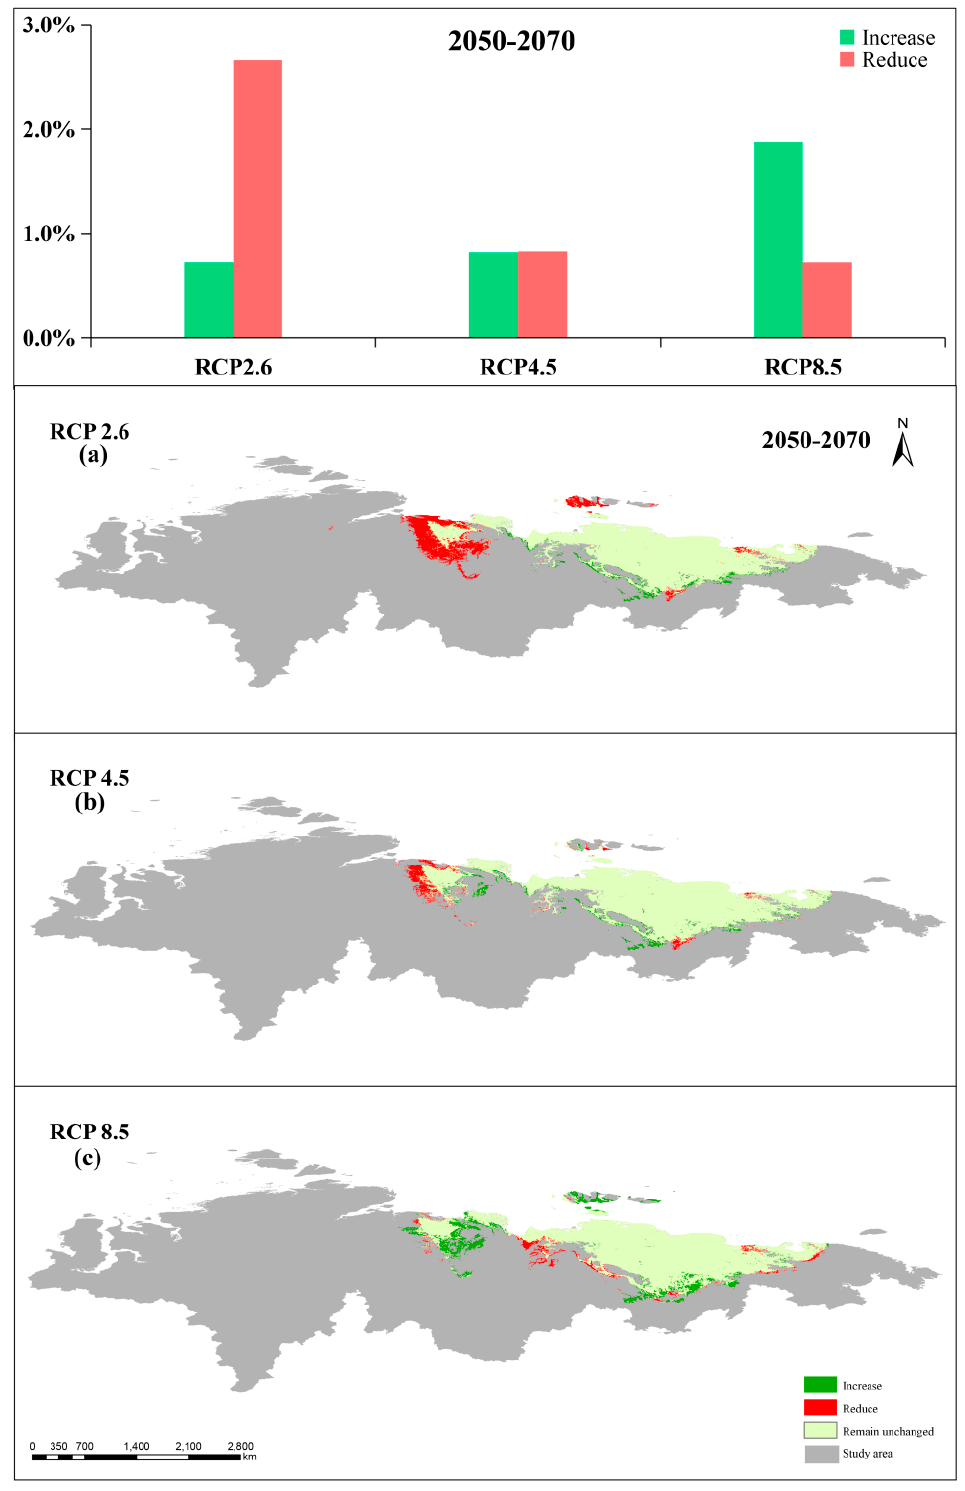
Figure 10. Increases and decreases in suitable breeding sites for lesser white-fronted goose under various climate change scenarios between 2050 and 2070: ( a ) 0.72% increase and 2.66% decrease under the RCP2.6 scenario; ( b ) 0.82% increase and 0.83% decrease under the RCP4.5 scenario; and ( c ) 1.88% increase and 0.72% decrease under the RCP8.5 scenario. Red represents the decreased area, and green represents the increased area.